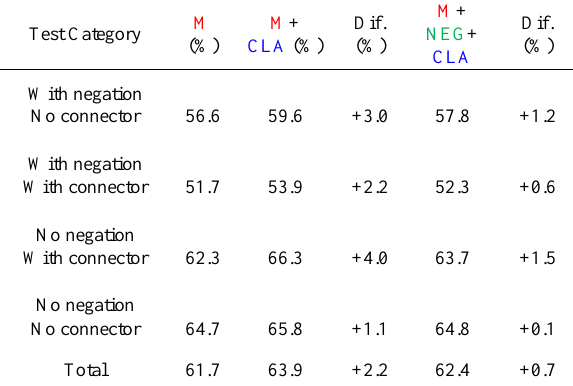
Table 3. Obtained results for global context kernel method with combination of negation and clause related feature sets in terms of f-measure.